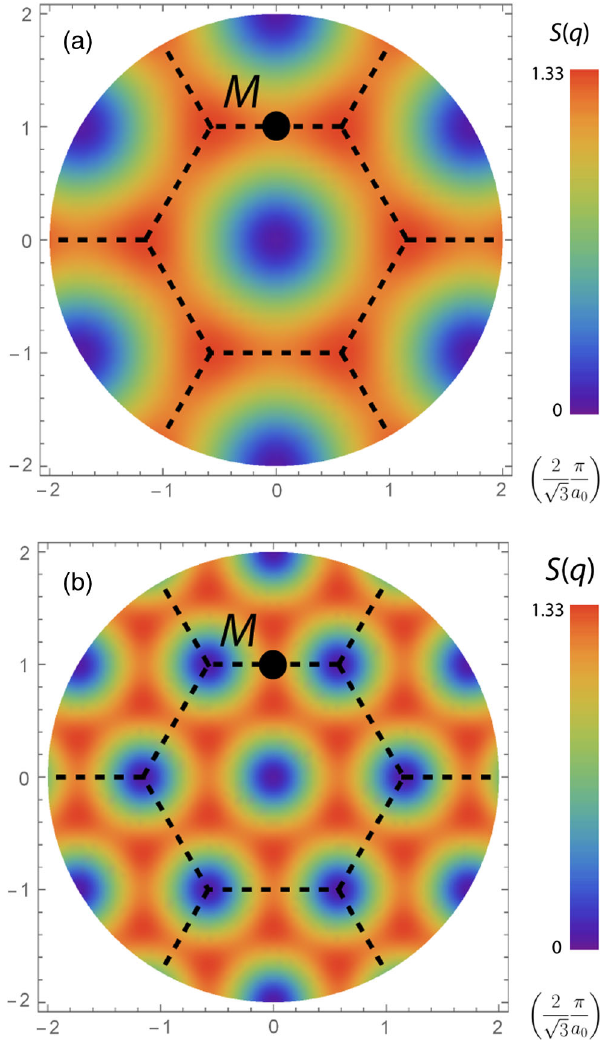
11. Spin structure factor for frozen random singlets. As in Fig. 5 but here plotted for the cases when the singlet bonds are either purely nearest neighbor (a) or purely second neighbor (b). Neither case reproduces the M peak position of Fig. the two intervening oxygen ions. [On the triangular lattice, ⃗ γ is fully determined by the bond orientation ⃗ r ij form an orthonormal coordinate system whose (1,1,1) axis is normal to the lattice plane.]